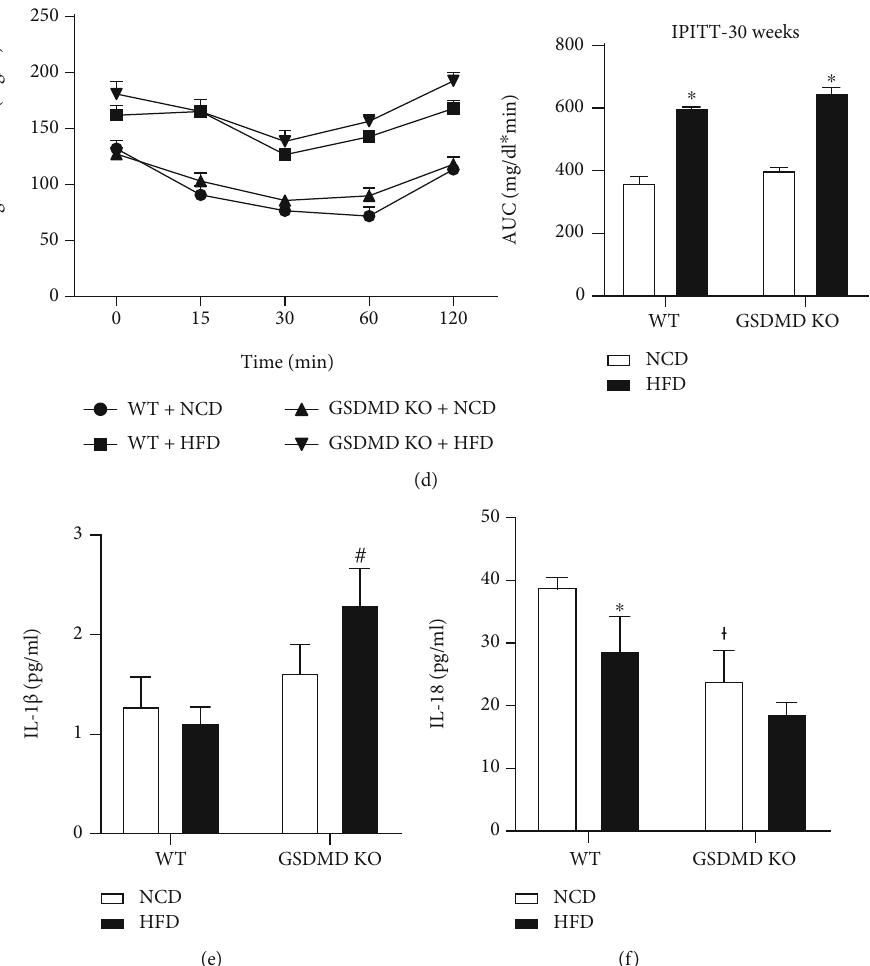
Figure 2: Glucose and insulin tolerance in wild-type (WT) and gasdermin D knockout (GSDMD KO) mice fed a high-fat diet (HFD). (a) Oral glucose tolerance test and (b) intraperitoneal insulin tolerance test performed at 15 weeks on a HFD in WT and GSDMD KO mice. Blood glucose levels were measured and the area under the curve (AUC) was determined. (c) Oral glucose tolerance test and (d) intraperitoneal insulin tolerance test performed at 30 weeks on a HFD in WT and GSDMD KO mice. Plasma IL-1 β (e) and IL-18 (f) measured by ELISA. ∗ p < 0 : 05 vs. same genotype mice fed a NCD, † p < 0 : 05 vs. WT NCD group, and # p < 0 : 05 vs. WT HFD